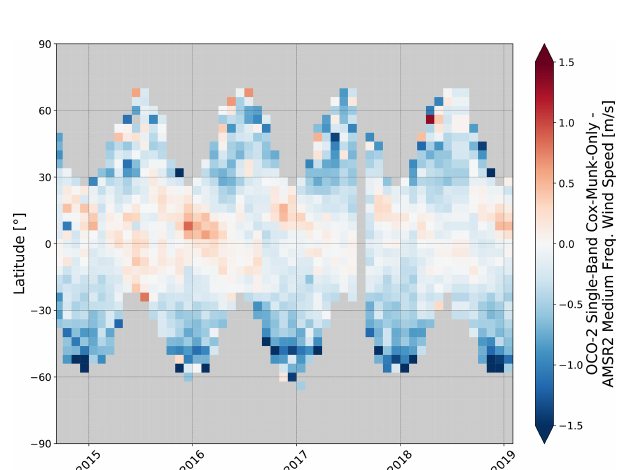
Figure 7. Heatmap of OCO-2 single-band Cox–Munk-only wind speed compared to AMSR2 medium-frequency wind speed as a function of time and latitude. The B9 lite file quality flag, custom filtering, and height scaling have been applied. The TSIS solar con- tinuum is